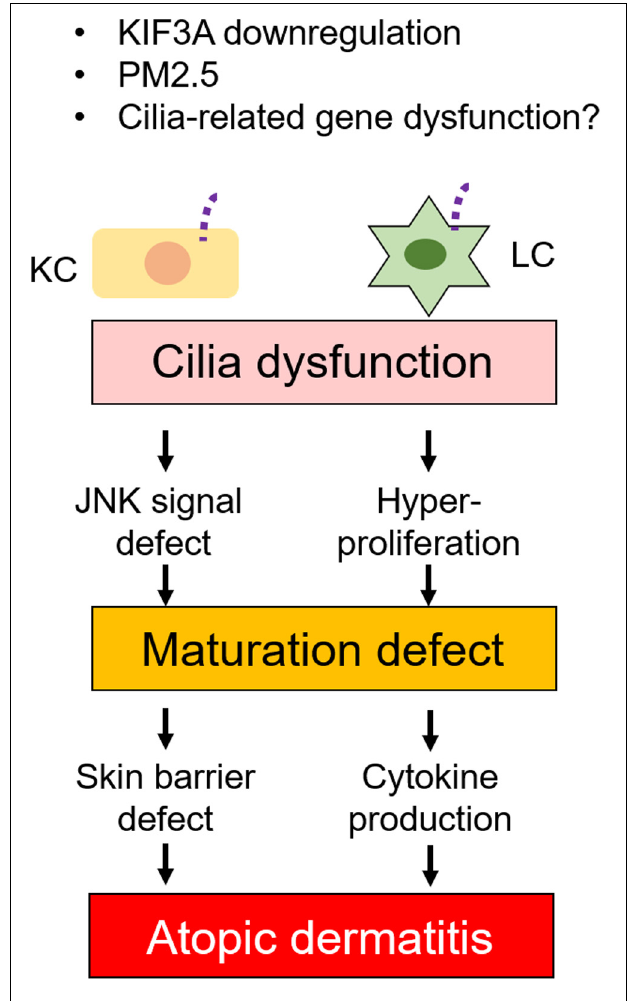
FIGURE 6 | Relation between primary cilia defects and skin disease. Dysfunction of primary cilia caused by ciliary gene defects or immunostimulants changes KC and LC phenotypes. Cilia dysfunction causes JNK signal and hyperproliferation in KC and LC, respectively. These, in turn, cause maturation defect in both KC and LC. Maturation defect then causes skin barrier defect and cytokine production in KC and LC, respectively. Cilia regulation may have potential as a drug